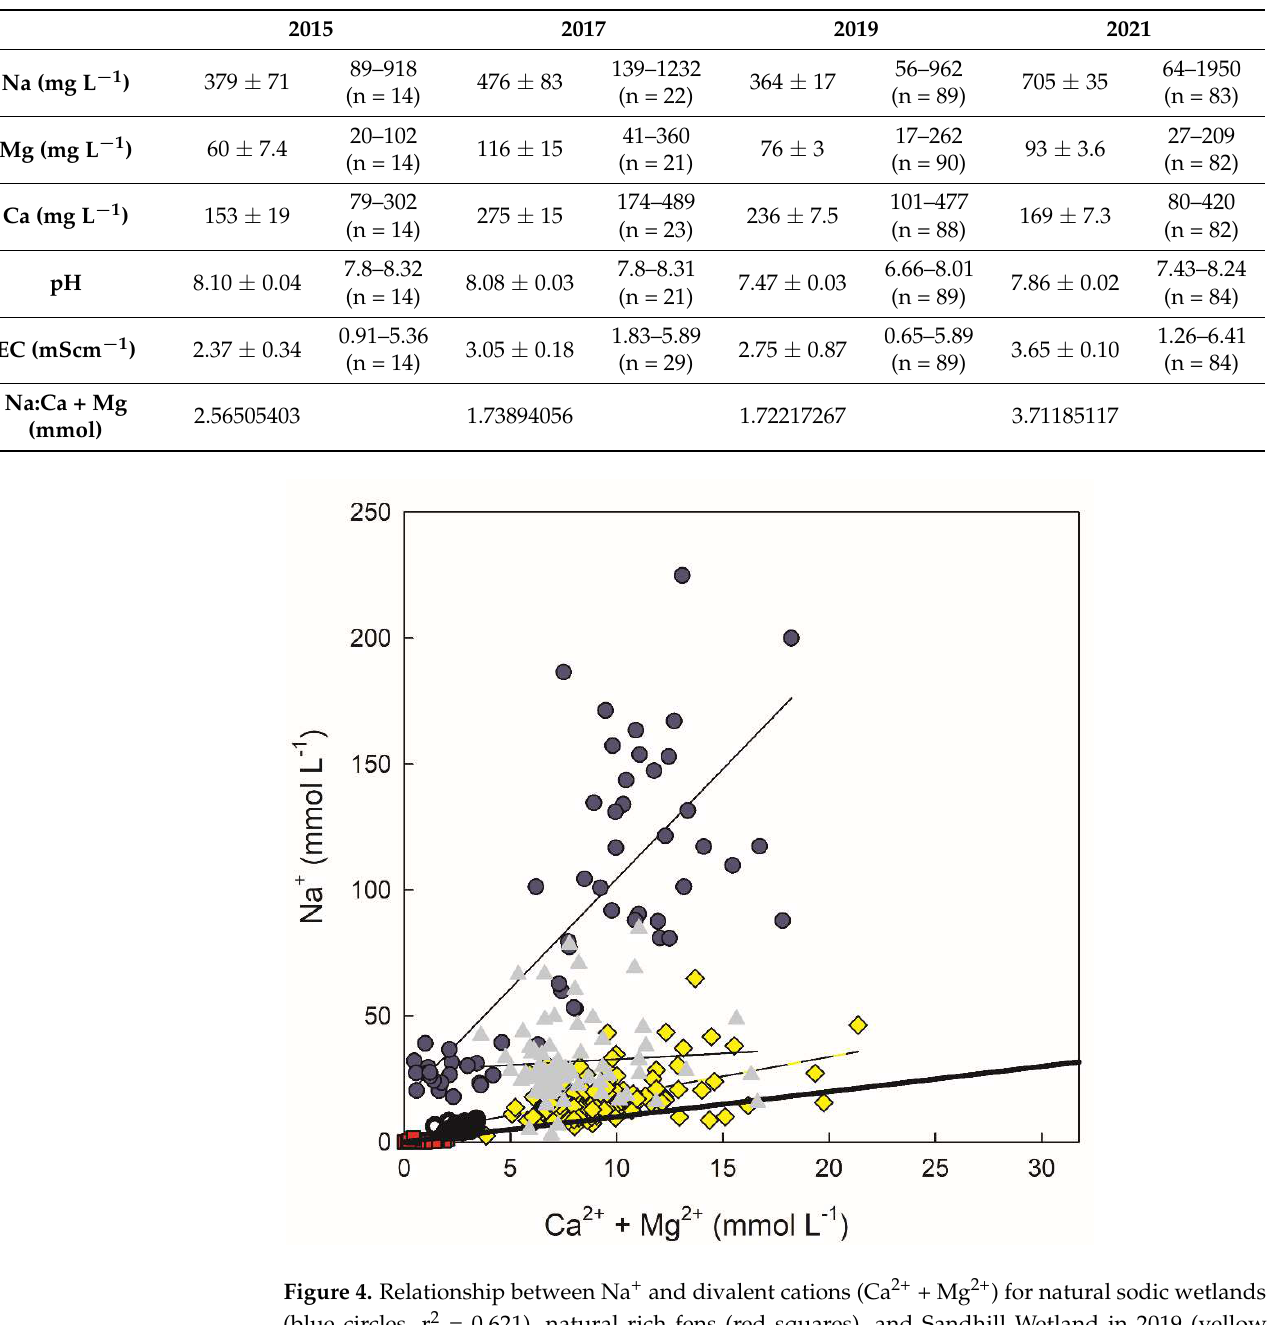
Table 3. Mean concentrations ( ± S.E.) and ranges of Na + , Ca 2+ Mg 2+ (mg L − 1 ), pH, and electri- cal conductance (EC, mS cm − 1 ) for Sandhill Wetland for 2015, 2017, 2019, and 2021. Ratios of Na + :Ca 2+ + Mg 2+ calculated as mmol L − 1 .